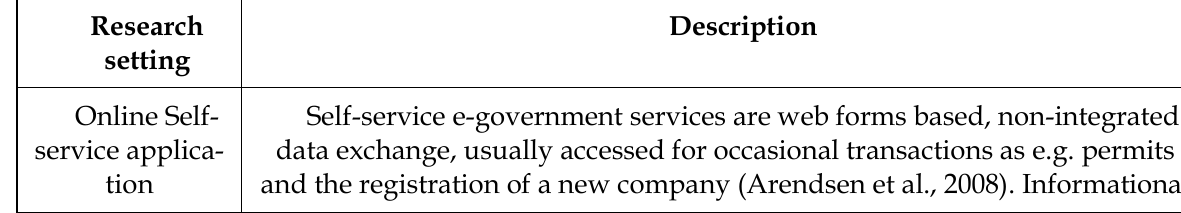
Table 1: Classification of research